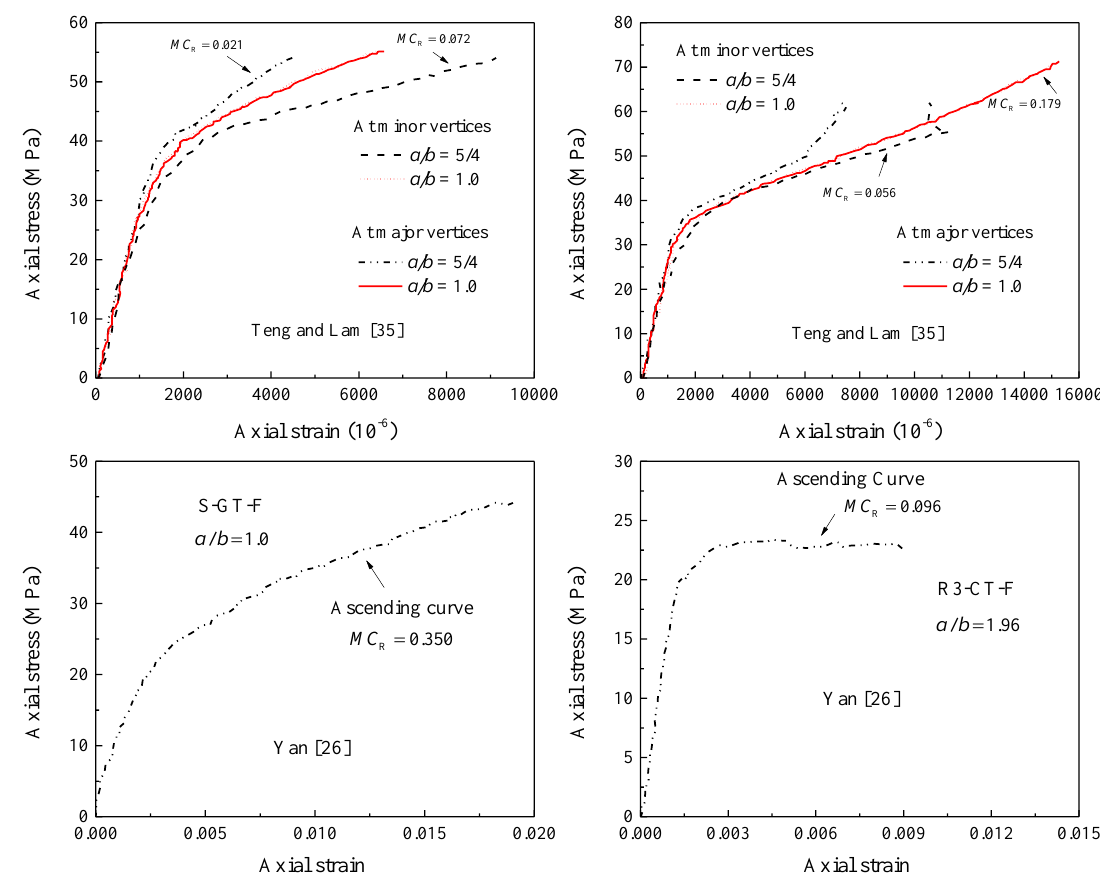
Figure 5. Accuracy of the proposed confinement pressure model MC R against selected stress-strain test responses of specimens in Table 1.